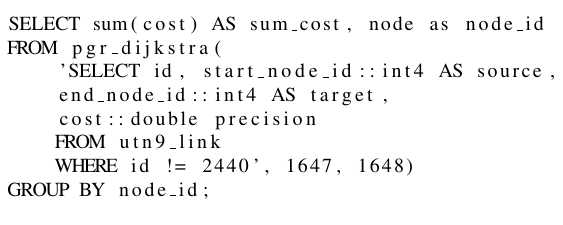
Figure 8. Example of a SQL statement to check the connectivity between two nodes (id=1647 and id=1648) with restricted access to the broken link (id=2440).